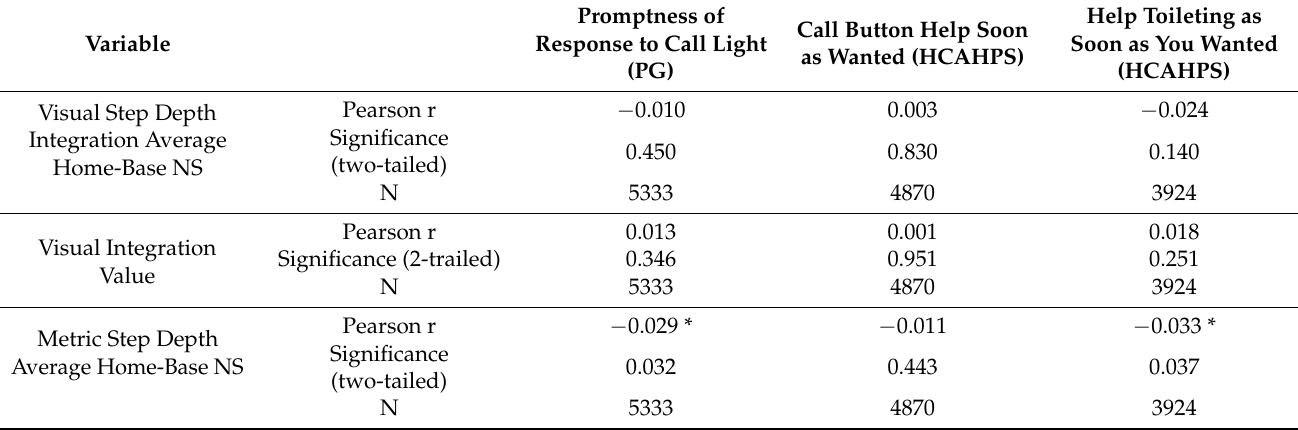
Table 5. Pearson correlation analysis on visibility and patients’ perception of staff’s promptness of response to call light and assistance when